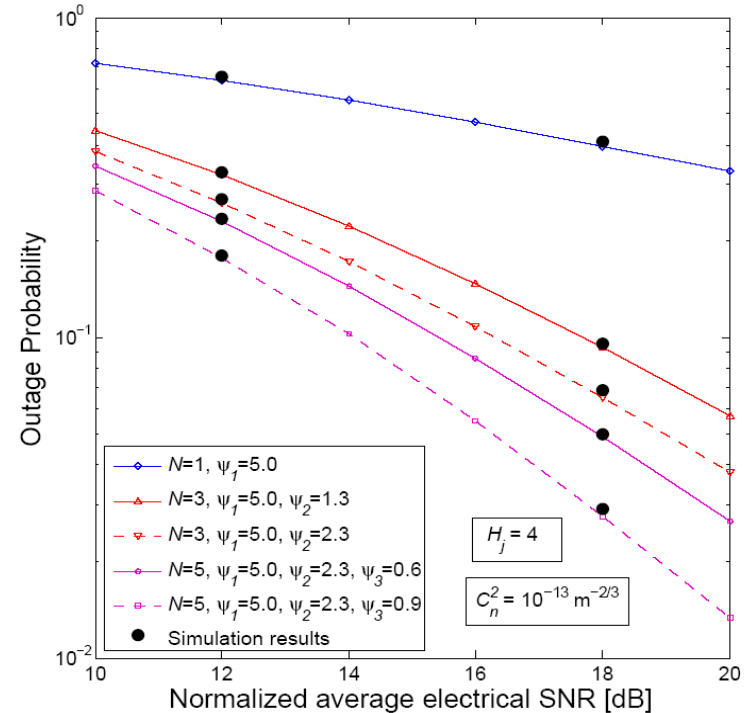
Figure 3. Total outage probability (OP) of a quadruple-hop relay-aided system with varying path configurations as a function of a wide range of γ / µ , for negative exponential (NE) modeled saturated turbulent channels along with different amounts of pointing mismatch.